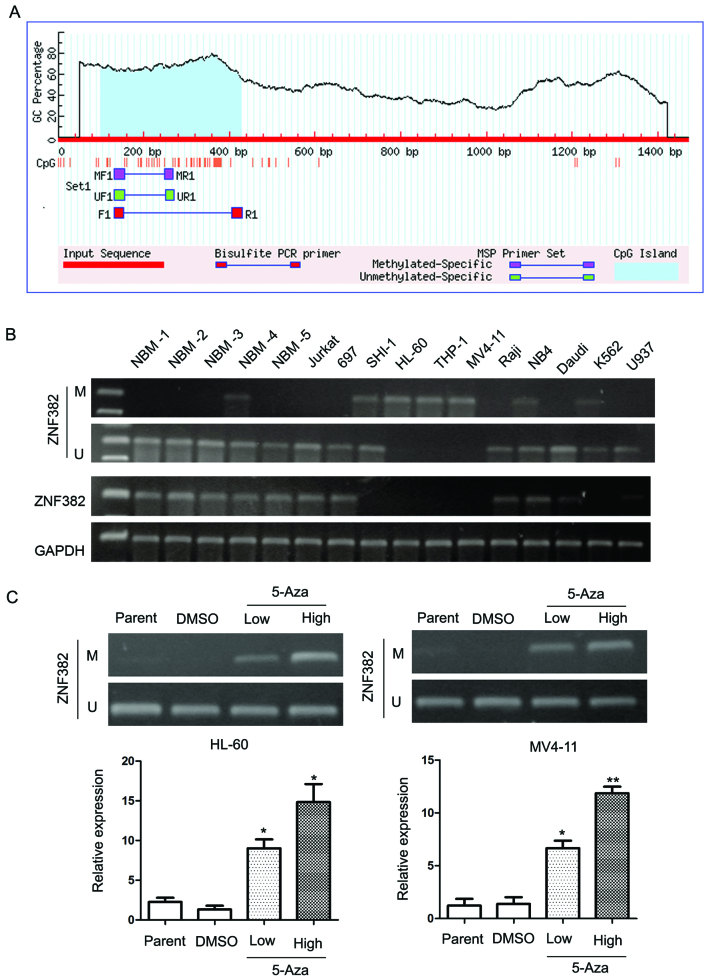
The zinc finger protein 382 (ZNF382) promoter is methylated in acute myeloid leukemia (AML) cell lines. (A) CpG island regions can be identified in the promoter of ZNF382. (B) Methylation analysis by methylation-specific PCR (MSP) shows ZNF382 hypermethylation in AML cell lines. M and U represent MSP results using primer sets for methylated and unmethylated ZNF382 genes, respectively. (C) The ZNF382 transcript level is upregulated in cells treated with 5-Aza compared with the DMSO control. Parent indicates the parent cell line.